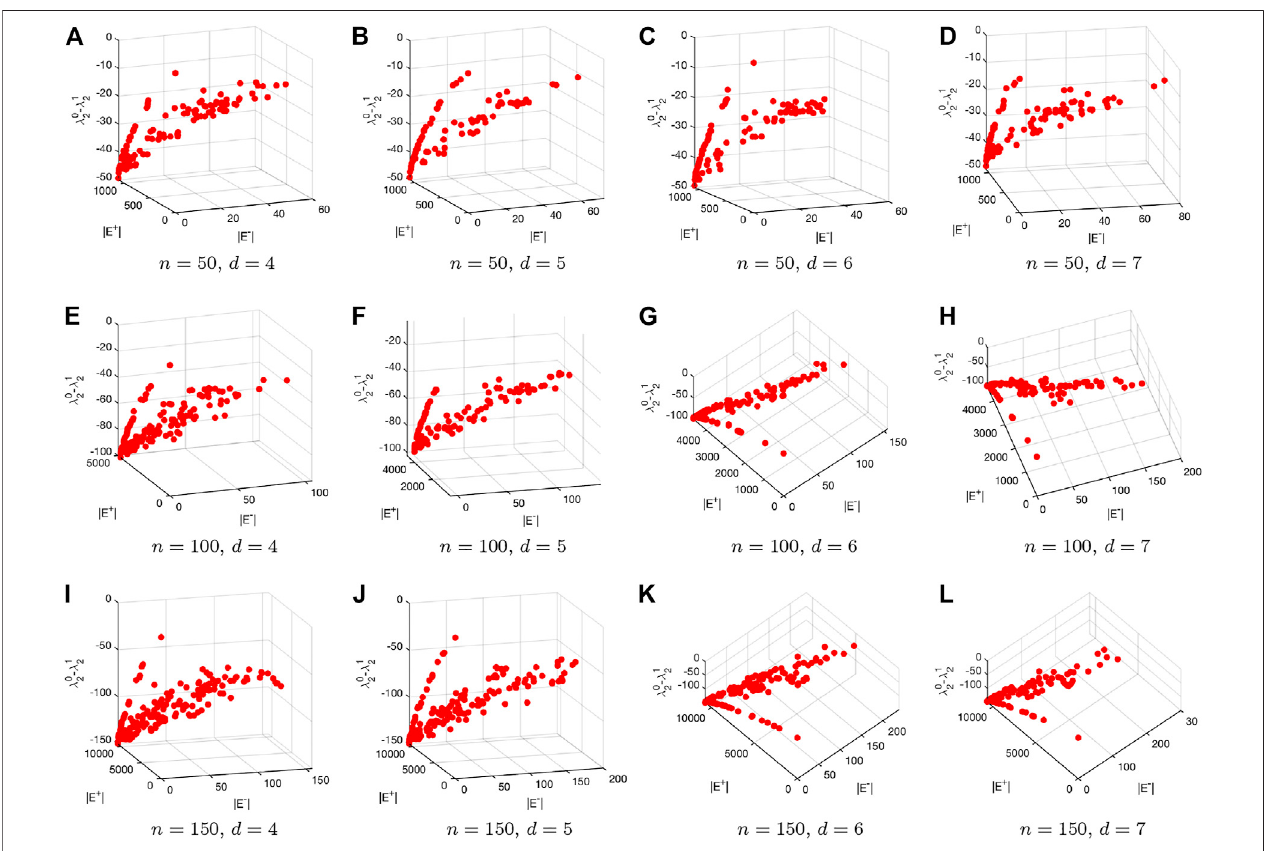
FIGURE 8 | Visualization of the Pareto fronts obtained by applying the introduced multiobjective particle swarm optimization algorithm to the generated Erd ő s – Rényi networks.